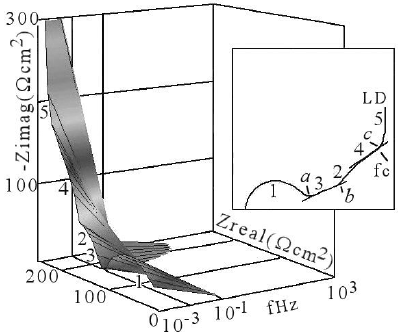
Figure 6. Nyquist diagram for palladium charged in hydrogen. Applied potential at potential between shoulder B and equilibrium potential, position